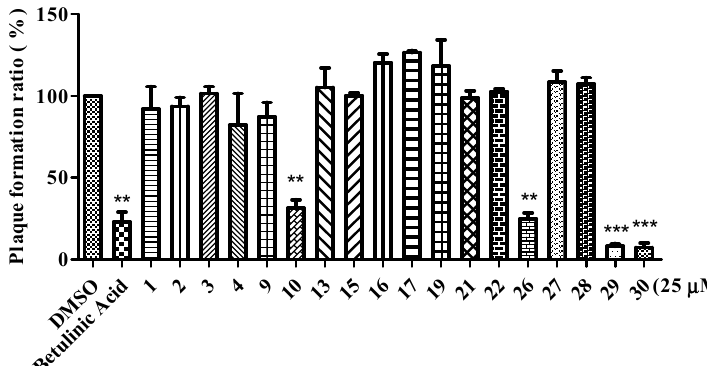
Figure 6. Anti-IAV activity of isolated compounds from the CLE layer. Cell viability is shown in the upper panel and plaque forming reducing shown in the bottom panel. DMSO was used as a solvent control and betulinic acid was used as a positive control. The data are presented as mean ± SD of three independent experiments and were normalized to the data of solvent control ( * p < 0.05, ** p < 0.01, and *** p < 0.001).